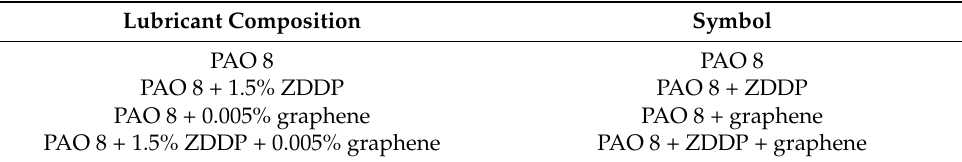
Table 1. Lubricants subjected to tribological testing.